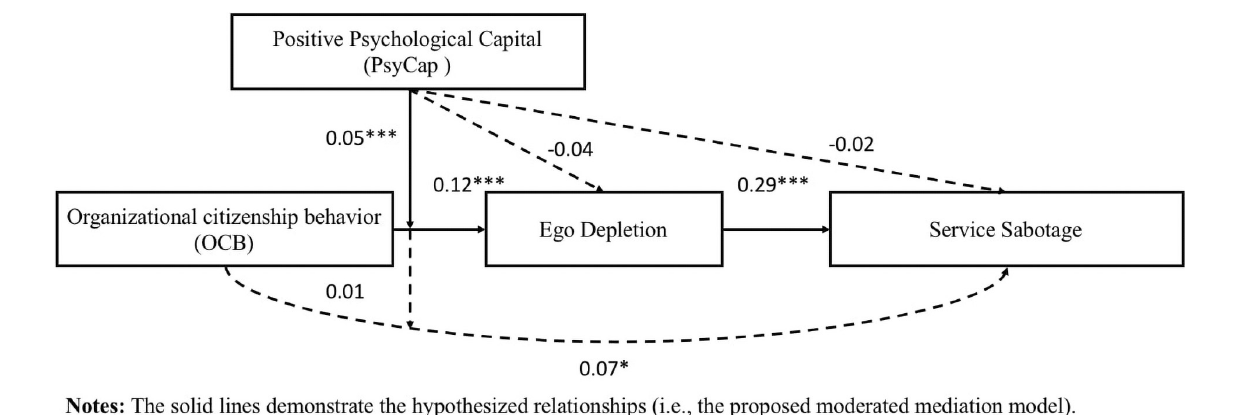
FIGURE 2 | Results of moderated mediation